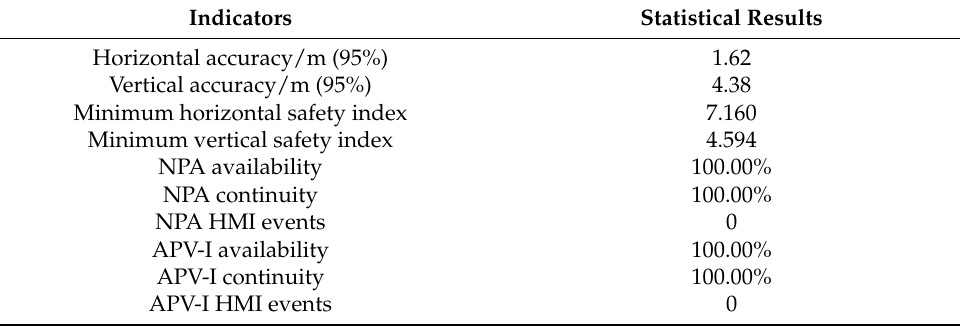
Table 2. BDSBAS SF performance statistics of flight test-I.